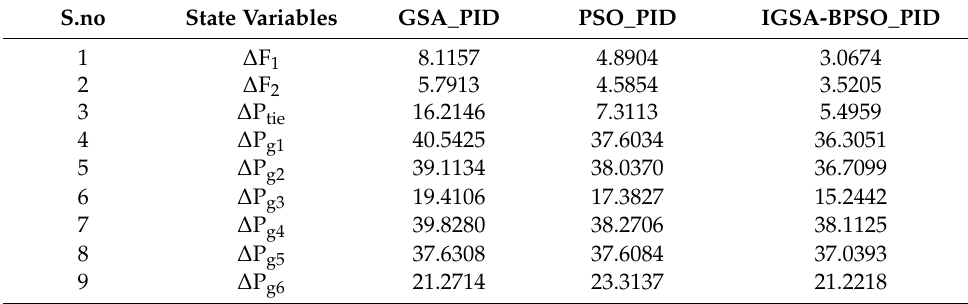
Table 5. Settling time values (s) for different optimization techniques (O.T.)—BBT.